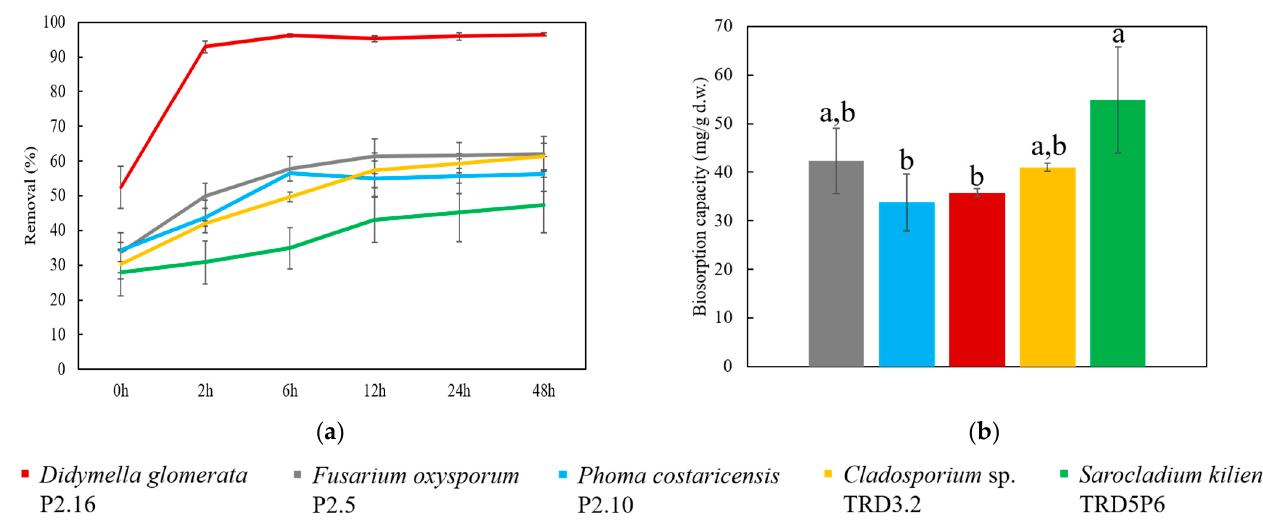
Figure 6. Mercury biosorption potential of five fungal isolates’ live biomasses from 100 mg/L Hg 2+ aqueous solution over 48 h, 120 r/min: ( a ) removal and ( b ) biosorption capacity; the values represent means, the error bars represent confidence intervals ( n = 3, 95% confidence level) and bars with different letters are significantly different (confirmed by Tukey test, p < 0.017).